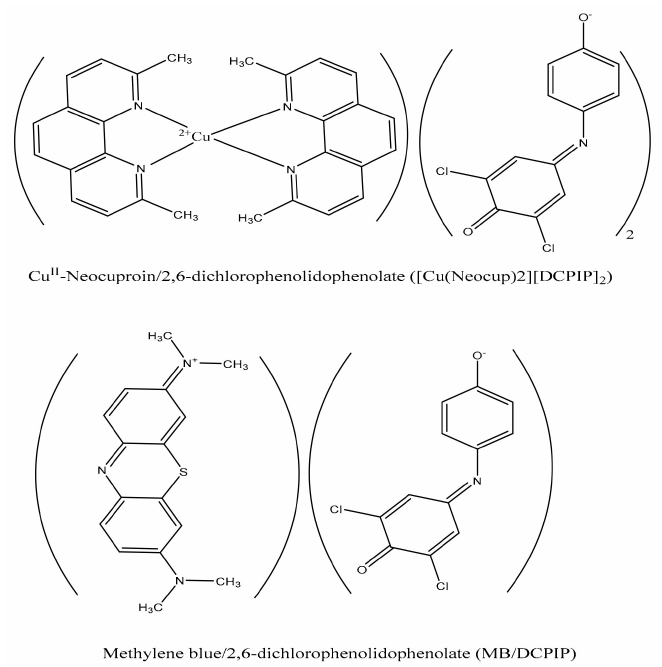
Figure 2. Structure of di ff erent ion pairs based on 2,6-DCPIP redox dye.